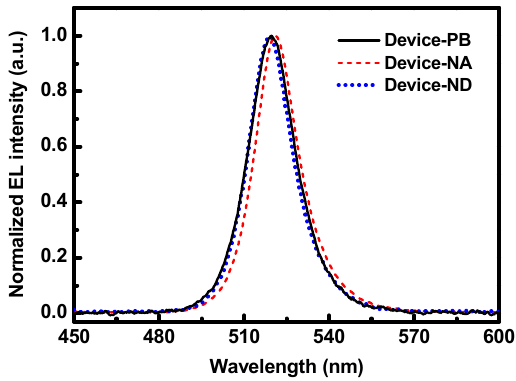
Figure 6. Normalized EL spectra of Device-PB, Device-NA, and Device-ND.